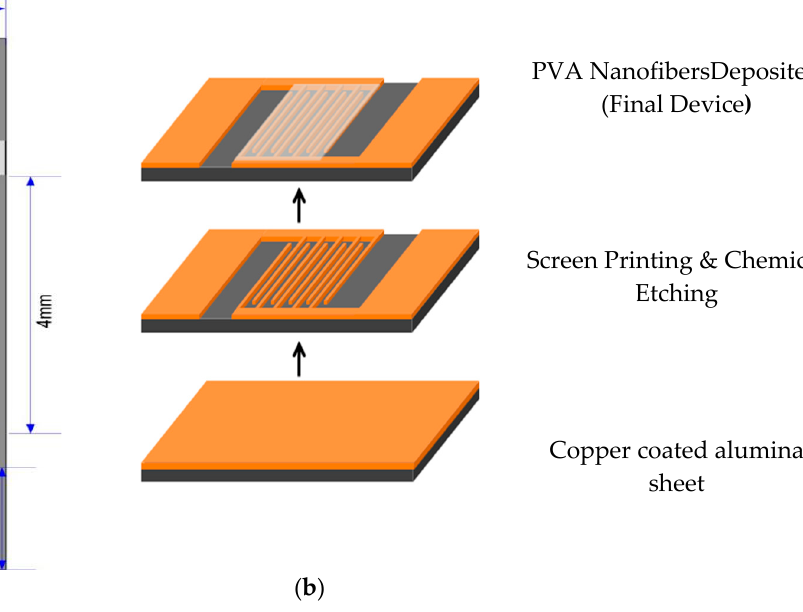
Figure 5. ( a ) Dimention ( b ) Printed diagrma ofinterdigitated electrode.